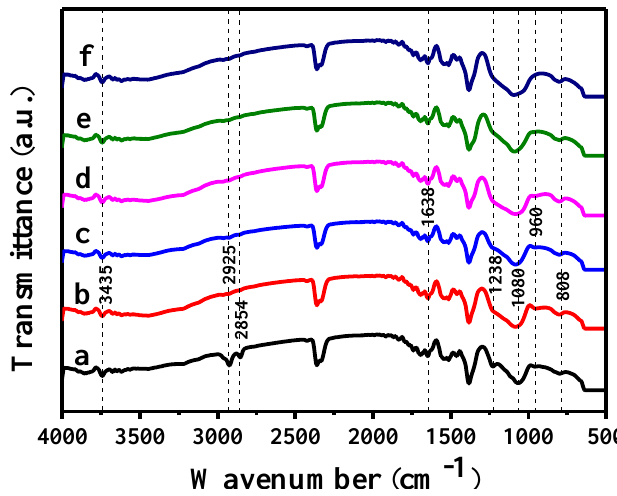
Figure 4. FT-IR spectrums for fresh catalysts. ( a ) MCM-41 before calcination, ( b ) MCM-41 after calcination, ( c ) 10% Ni / MCM-41, ( d ) 5% Ni-MCM-41, ( e ) 10% Ni-MCM-41, and ( f ) 15% Ni-MCM-41.